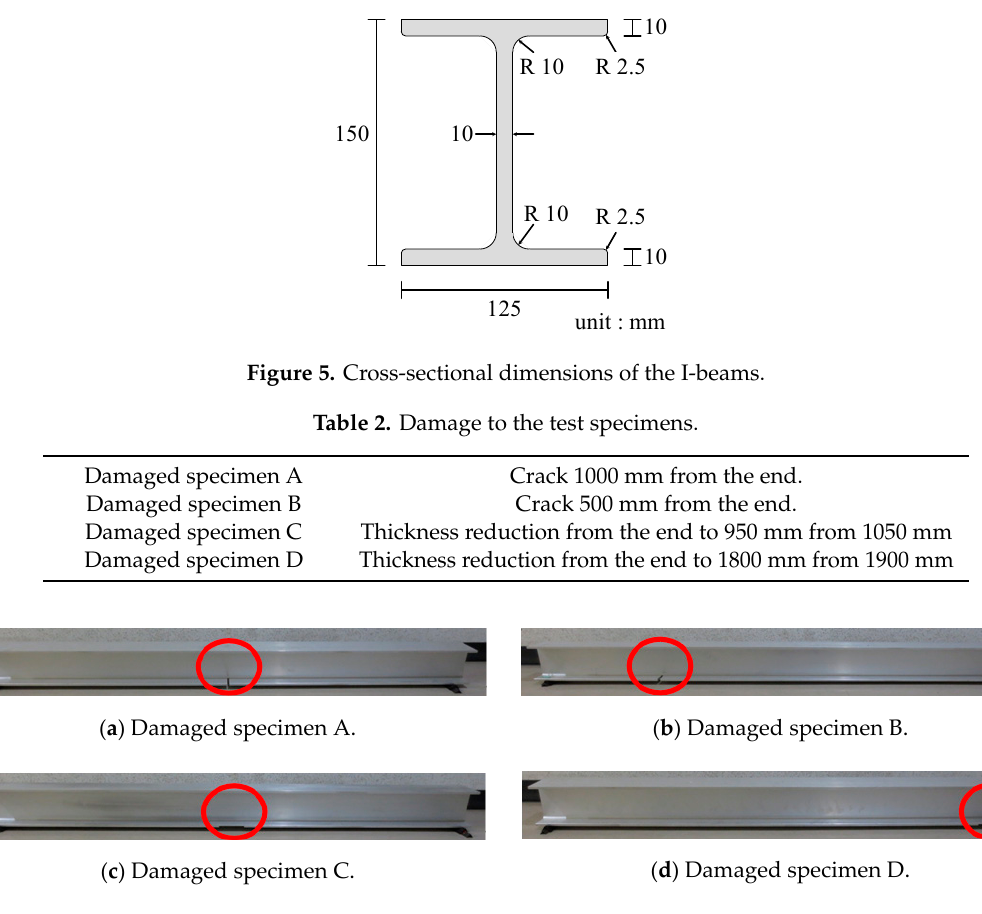
Figure 6. Damaged specimens A to D (The area indicated by the red circle is the damaged area).